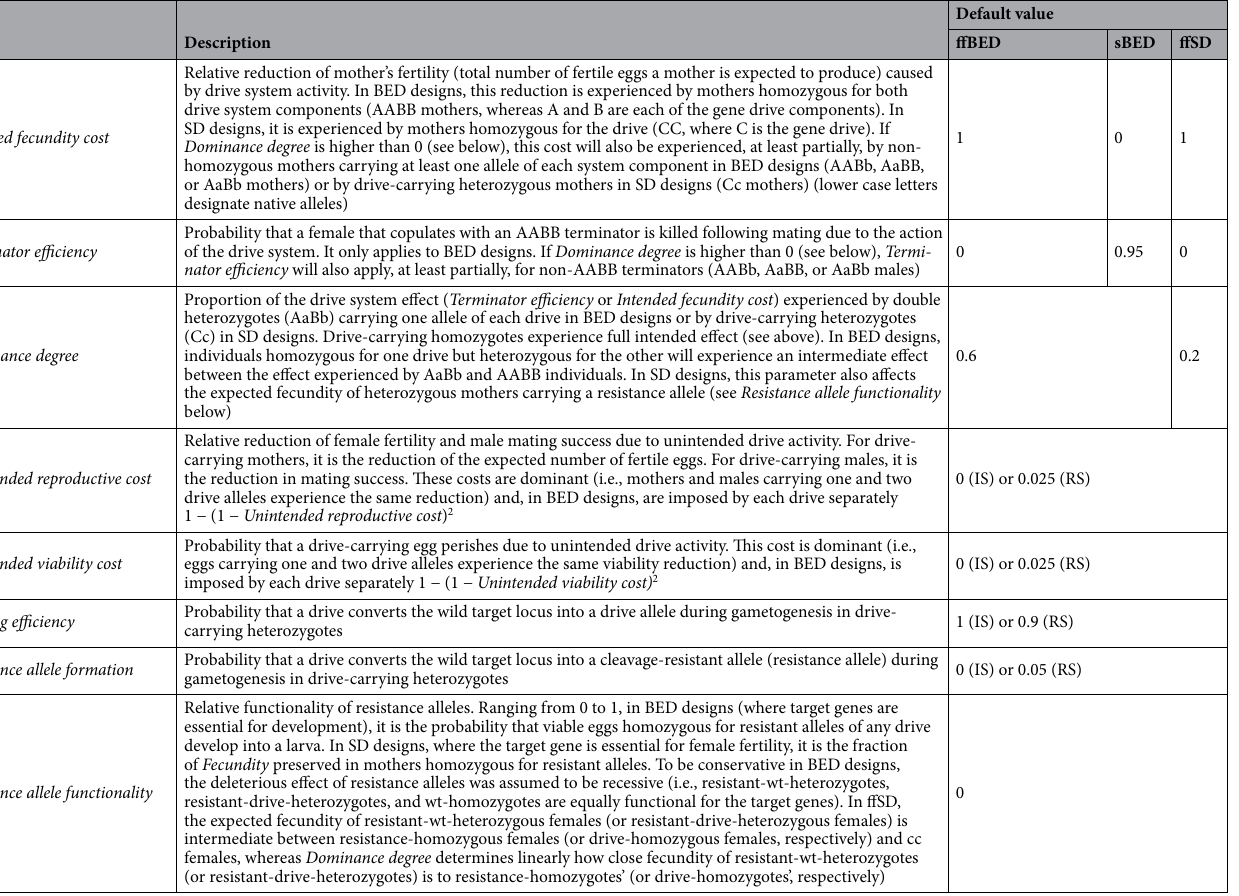
Table 2. Main system parameters. A description and the default value(s) are shown for each parameter. For the three parameters related to intended drive effects, the default value may vary between designs (ffBED, sBED, and ffSD). For the four parameters related to drive endonuclease activity and unintended fitness cost, two default values are included: one for a system with ideal drive activity [Ideal System (IS)], that has perfect conversion rate and does not impose unintended fitness costs, and the other for a system with reference drive activity [Reference System (RS)], with imperfect conversion and unintended fitness